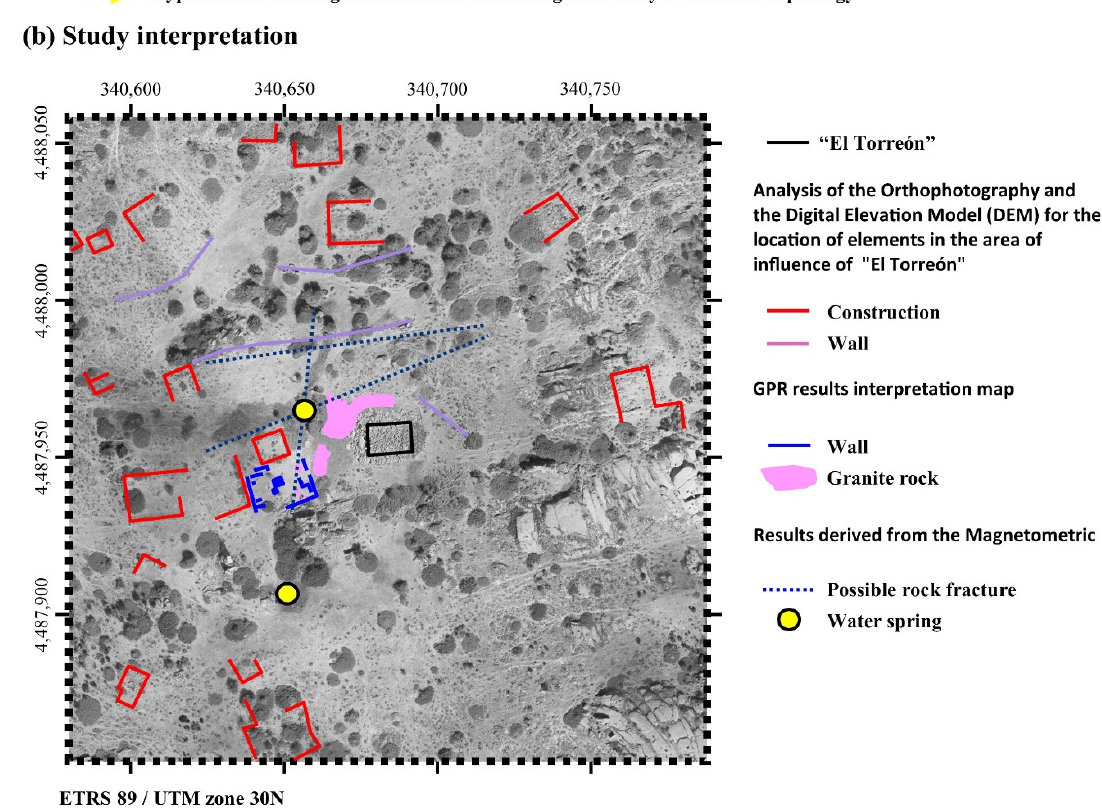
Figure 13. Images showing the hypothesis based on the results of the study. ( a ) Possible rock fracture detected with geophysical methods and orthophoto. ( b ) Location of other large buildings near “El Torreón”.